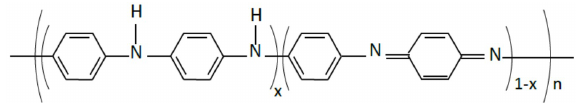
Figure 1. Fourier transform infrared (FTIR) spectra of pure polyaniline (PANI), zinc oxide (ZnO), and PANI/ZnO composites.